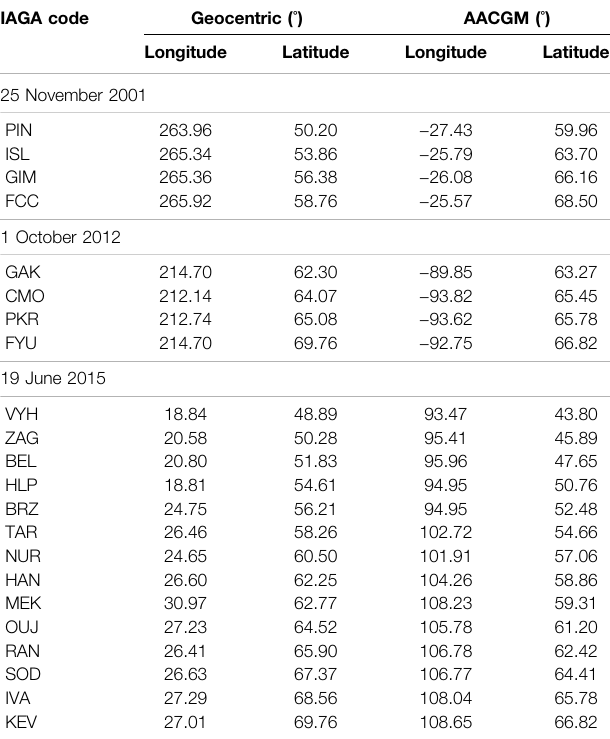
TABLE 1 | Magnetometers in the CARISMA, Alaskan Fairbanks, EMMA and IMAGE magnetometer chains. The geocentric, and AACGM longitudes and latitudes are listed for each